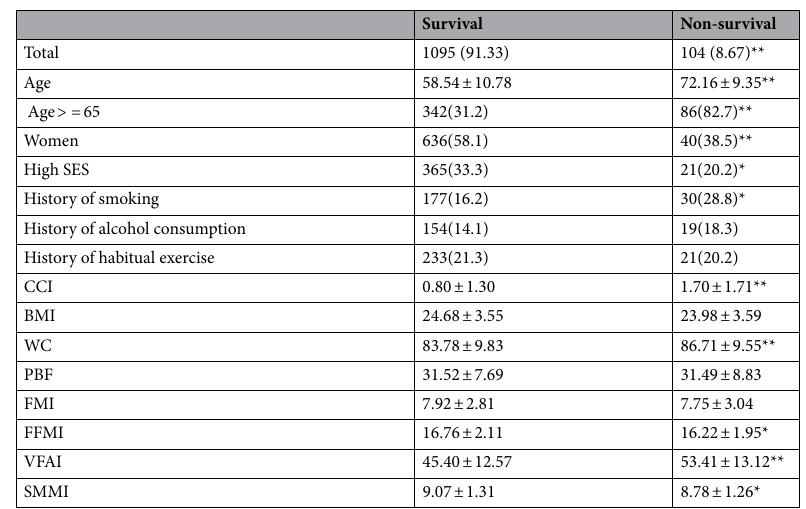
Table 1. Baseline demographic characteristics of the subjects between (N = 1,199). Continuous data was analyzed using an independent t-test and was represented as mean ± SD. Dichotomous data was analyzed with a chi-square test and represented as N (percentile). SES: socioeconomic status; CCI: Charlson comorbidity index; BMI: body mass index; WC: waist circumference; PBF: percent body fat; FMI: fat mass index. FFMI: fat free mass index; VFAI: visceral fat area index, and SMMI: skeletal muscle mass index. * p < .05; ** p < .001.